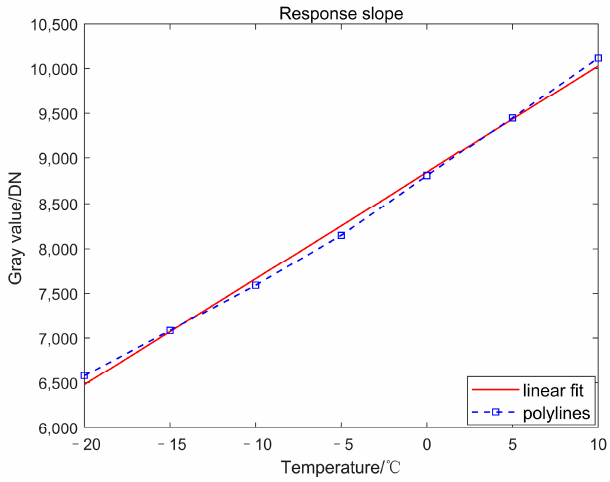
Figure 7. Response slope of IRFPA.